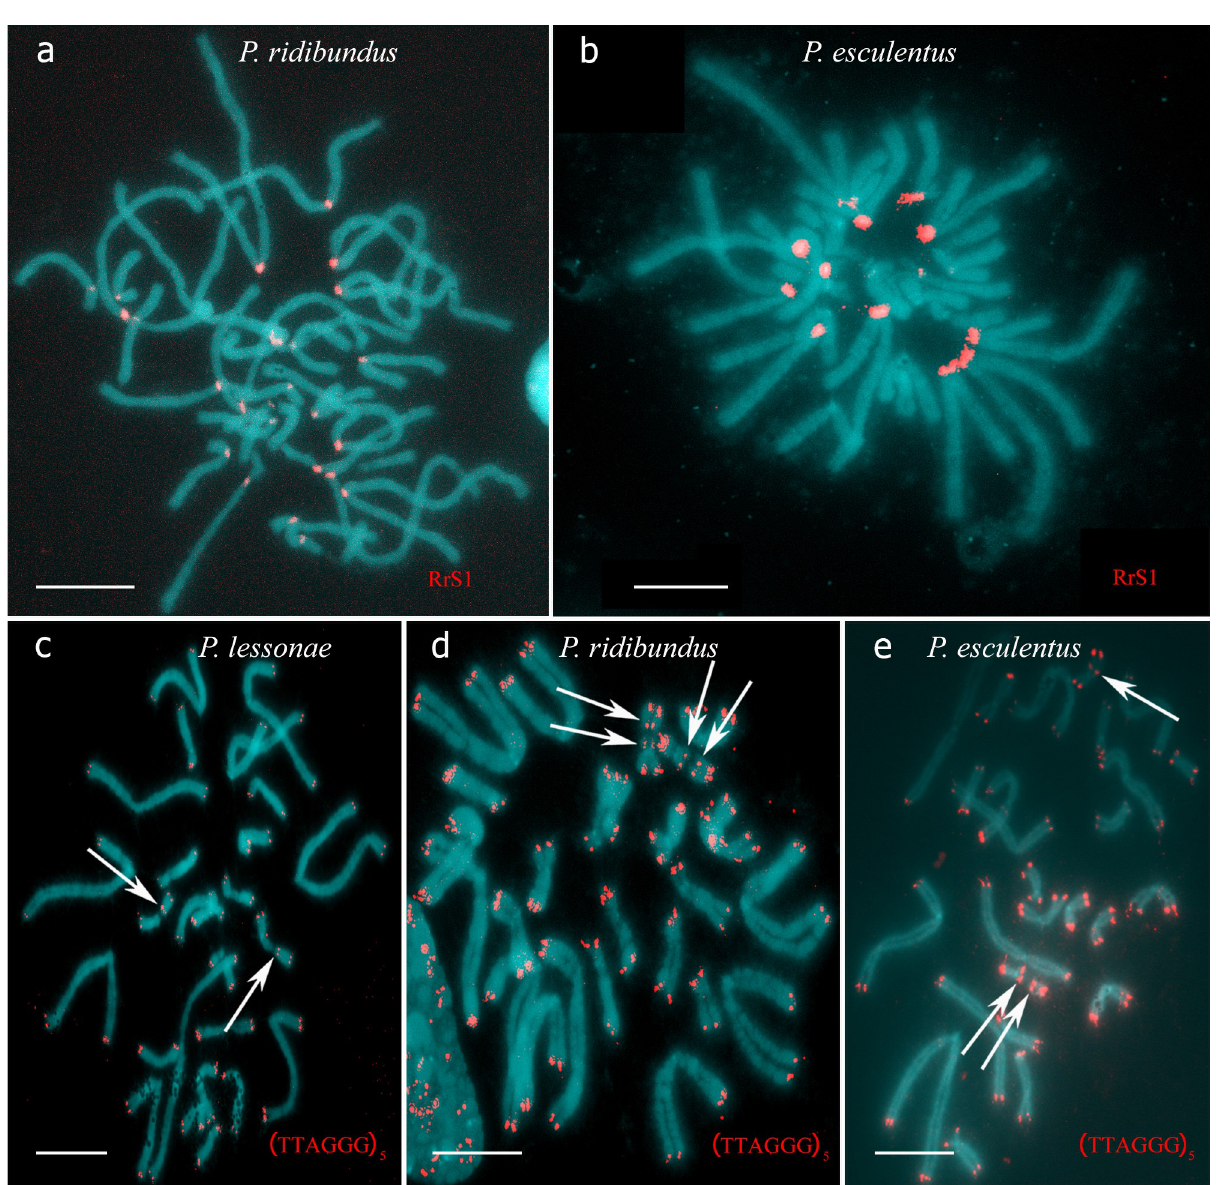
Fig 1. Water frog karyotype identification using FISH with species-specific markers to centromeric repeat (RrS1) and interstitial (TTAGGG) n repeat sites (ITSs). Metaphase chromosomes after FISH using the centromeric probe (RrS1) (a, b), which detects only P . ridibundus but not P . lessonae centromeres (a, b). Metaphase chromosomes after FISH using the probe to (TTAGGG) n repeat, which distinguishes one or two ITSs (arrows) in parental NOR-bearing chromosomes (c-e). Parental species were identified as P . ridibundus (a, d) and P . lessonae (c), while tadpoles were identified as diploid hybrids (b, e). Scale bars = 10 μ